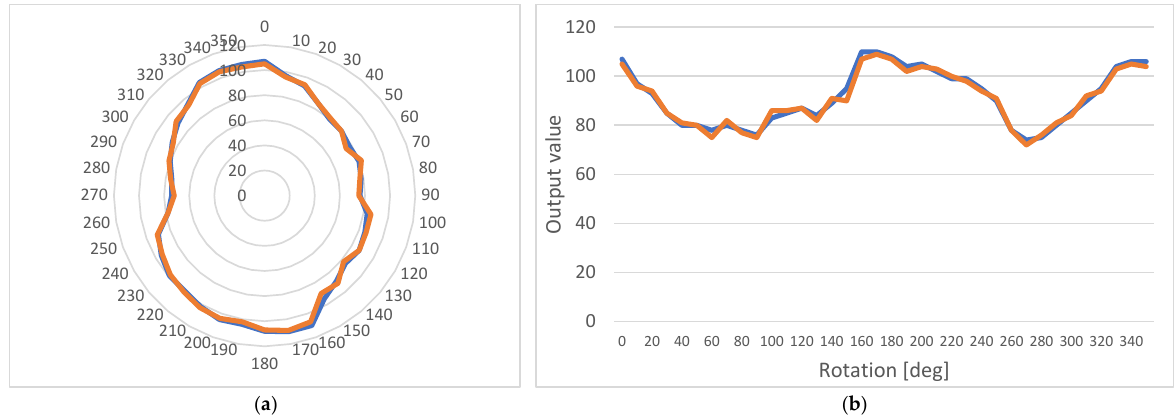
Figure 21. Anisotropic behavior of the sample after the flaw was added; measurement on point (orange line) and with a 5 mm offset (blue line): ( a ) A polar diagram; ( b ) A linear diagram.